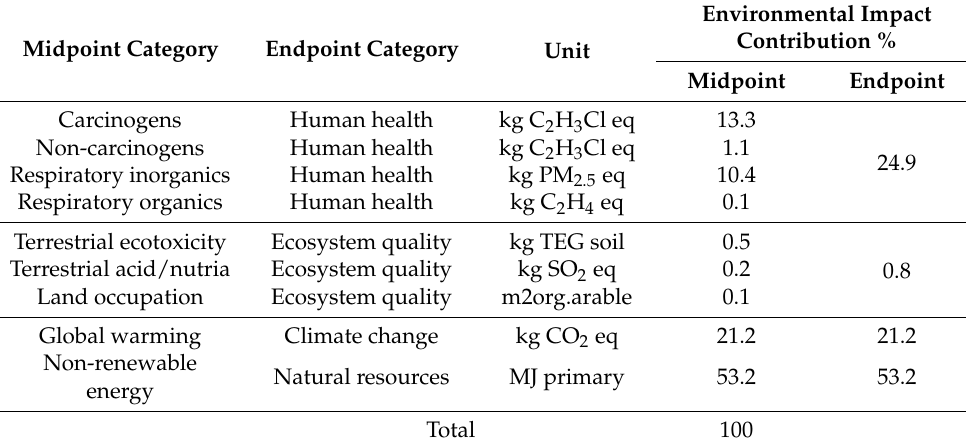
Table 3. Percentage contribution of environmental impact categories in SimaPro for